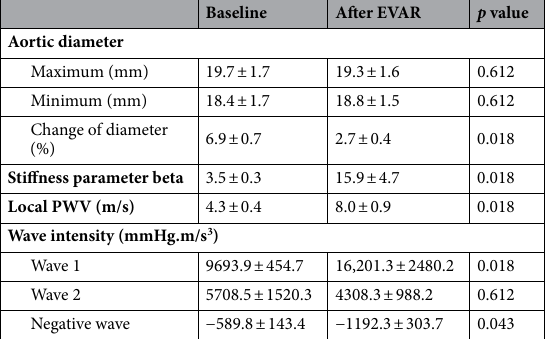
Table 2. Change in aortic diameters, stiffness parameter beta, local PWV and wave intensity at baseline and after stent-graft. Value, mean ± SE; PWV pulse wave velocity by Bramwell–Hill equation.